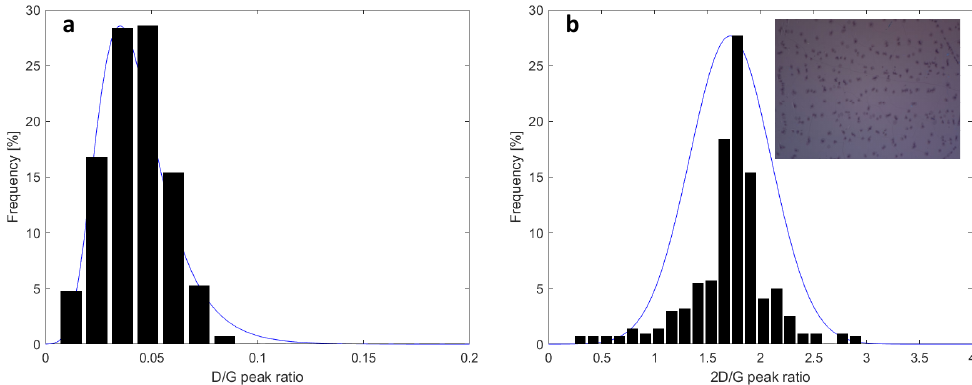
Figure 2. ( a ) The Raman histogram of the ratio of D band to G band intensity. ( b ) The Raman histogram of the ratio of the 2D band to G band intensity. Inset, an optical image of the